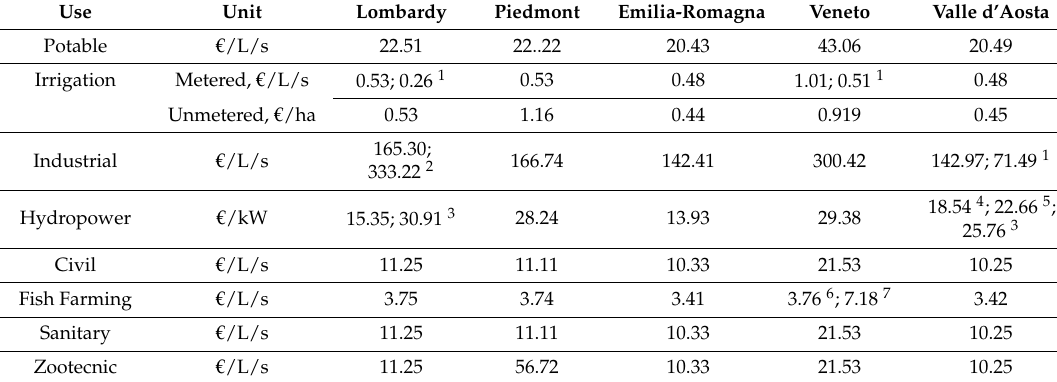
Table 4. Water abstraction fees (as in 2014) for the major water uses across the PRBD regions. Source: own elaboration from [60–64]. Legend: 1 abstraction with return; 2 abstraction > 3000 L/s; 3